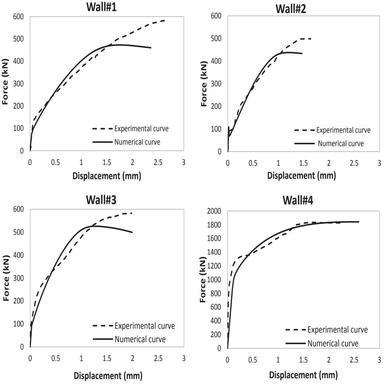
Comparison between experimental and numerical force - displacement (kN - mm) curves after the calibration of the macro-modelling approach.